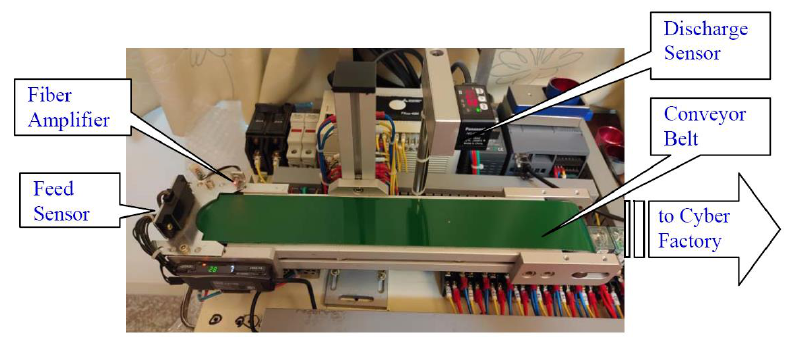
Figure 2. Material color discrimination system architecture.